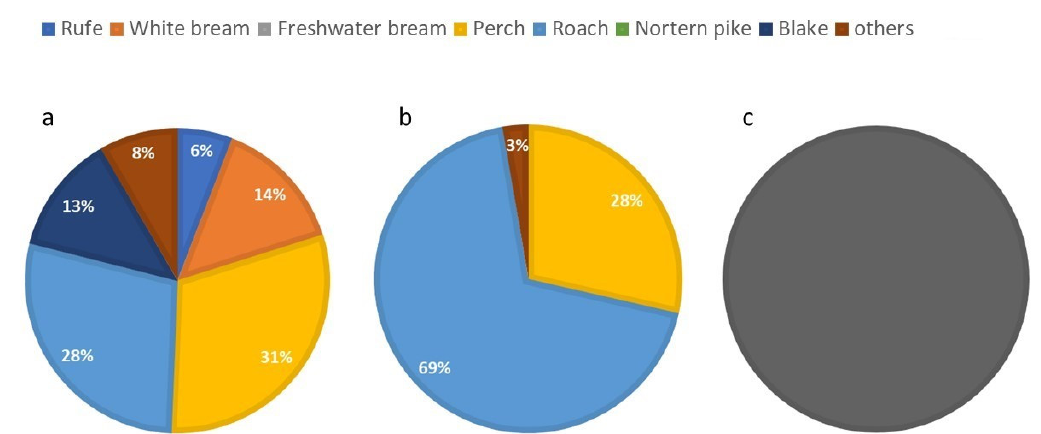
Figure 9. Comparison of the percentage of the main fish species in the total number of fish caught (( a )—Domysławskie Lake; ( b )—Gardno Lake; ( c )—Stara Kredownia).